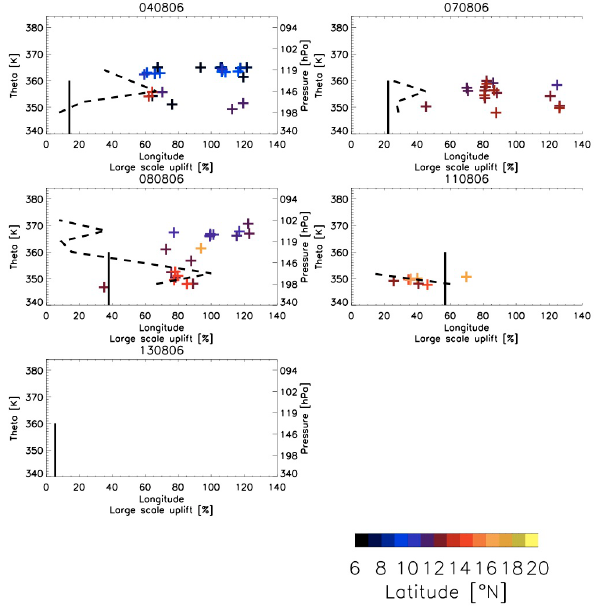
Fig. 9. Fraction of air masses influenced by large-scale convec- tive uplift (%) calculated using 10 day back trajectories arriving along M55 flights in 4K bins between 340K and 375K over West Africa for each local M55 flight (dashed lines). Also shown are av- erage longitudes where air masses arriving along local flights were uplifted irreversibly above 650hPa coloured by latitude where air masses were sampled by the M55. The average fraction of back trajectories from flight tracks between 350–360K coinciding with MSG cloud tops (%) are shown as a vertical bar as an indicator of local convective impact (see text for details).